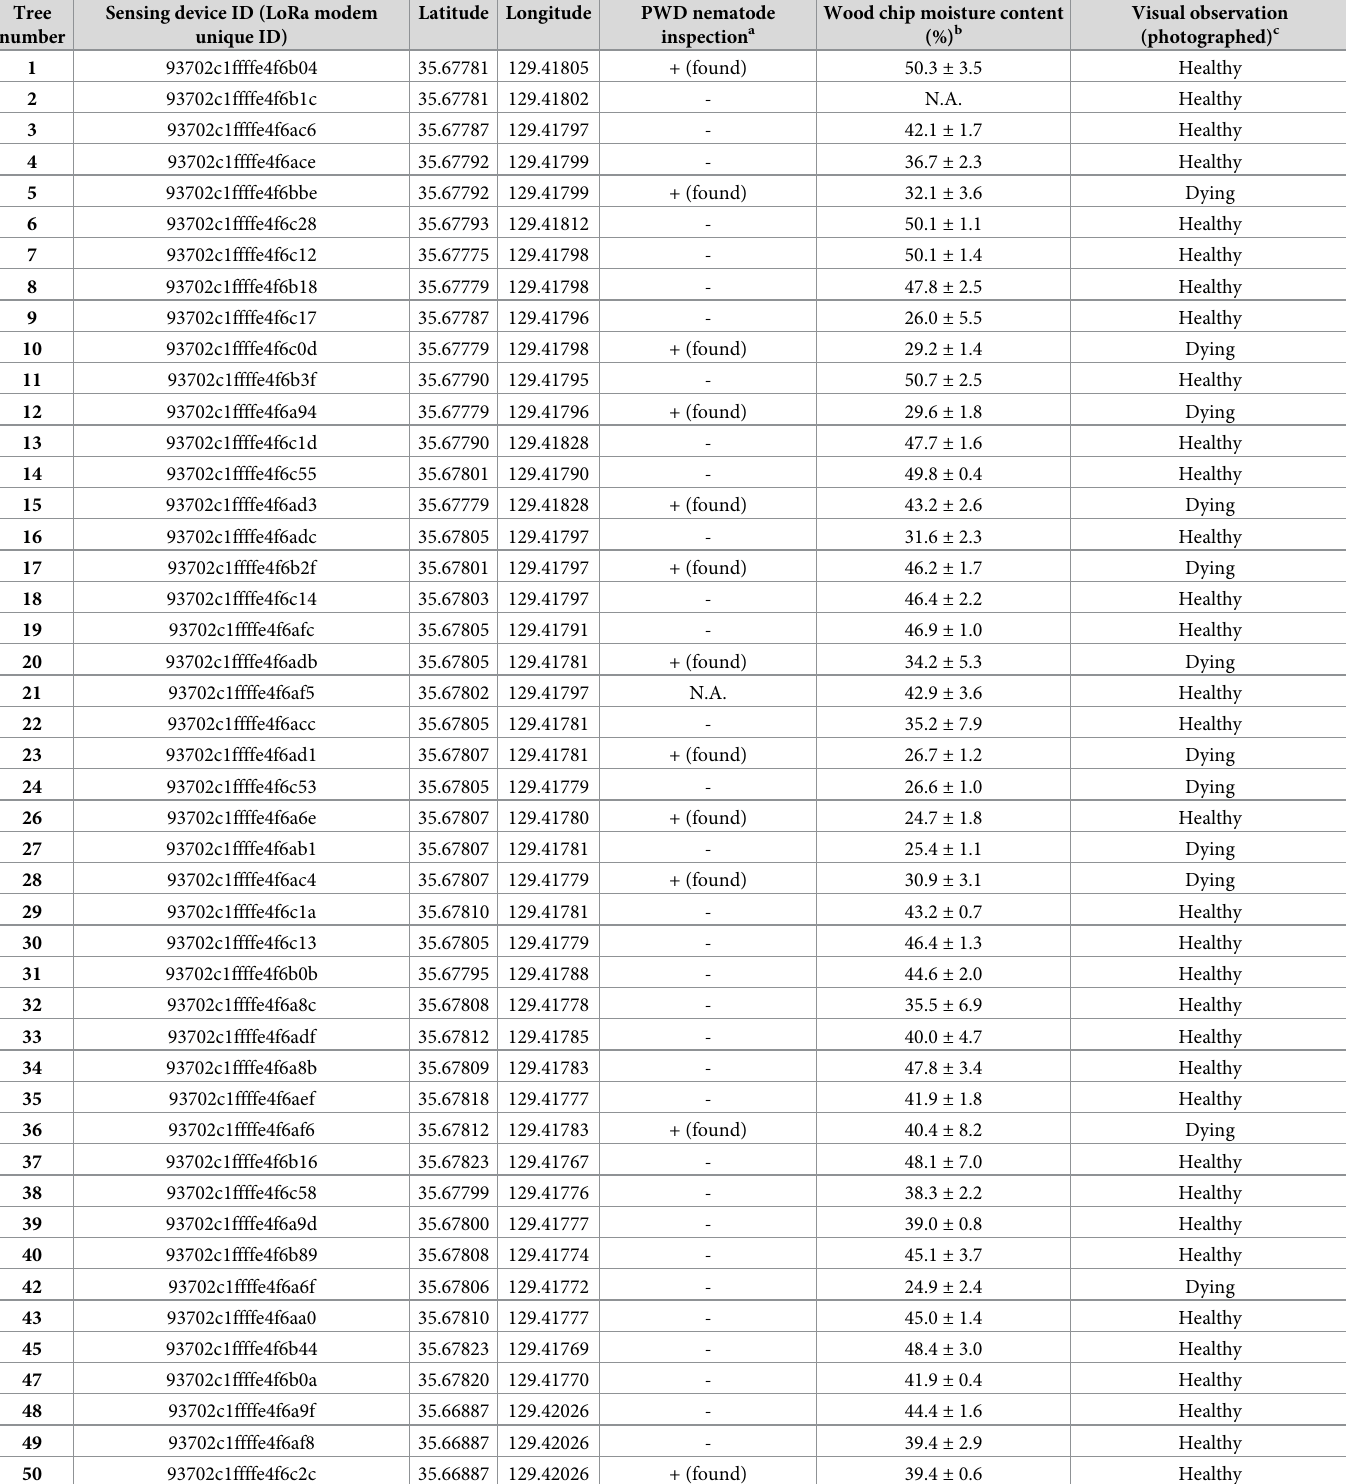
Table 1. Sensing device installation location and tree inspection results in Gyeongju. Tree